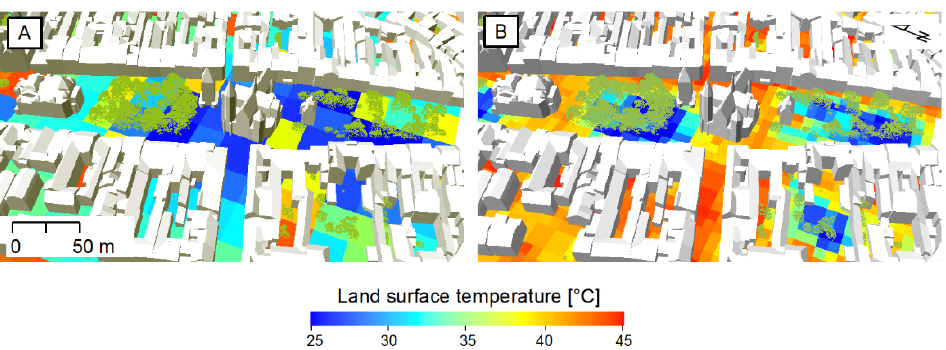
Figure 8. ( A ) Detailed view of LST derived from Landsat 8 satellite at 30 m resolution (LST 30m ); ( B ) downscaled LST at 10 m resolution (LST 10m ), over the 3D model of Košice city center (source of 3D model of Košice: © Institute of Geography, Košice).